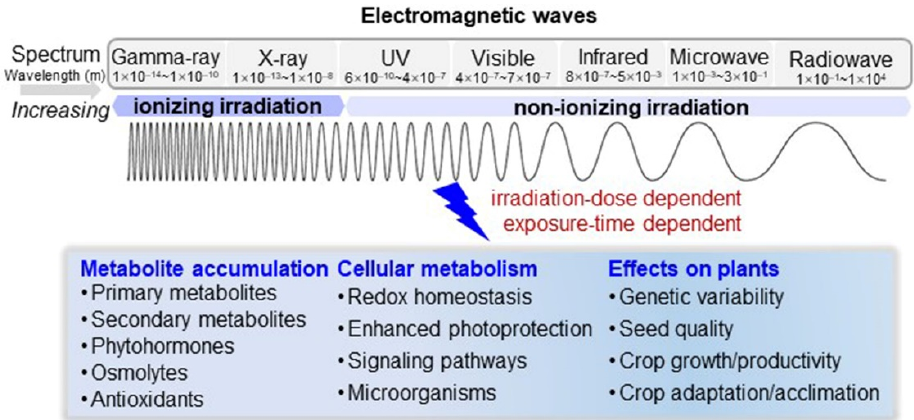
Figure 4. Summarizing overview of electromagnetic-wave irradiation on plants. Physical properties of spectral bands of electromagnetic waves are indicated. Electromagnetic-wave irradiation induced metabolite shifts and cellular metabolisms that were associated with plant growth and environment adaptation are summarized based on published studies on plants irradiated with electromagnetic waves.